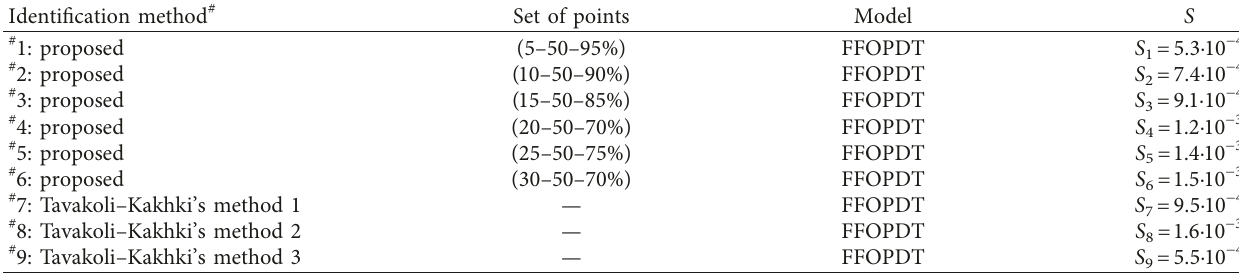
Table 23: Time-domain model performance indices for process P